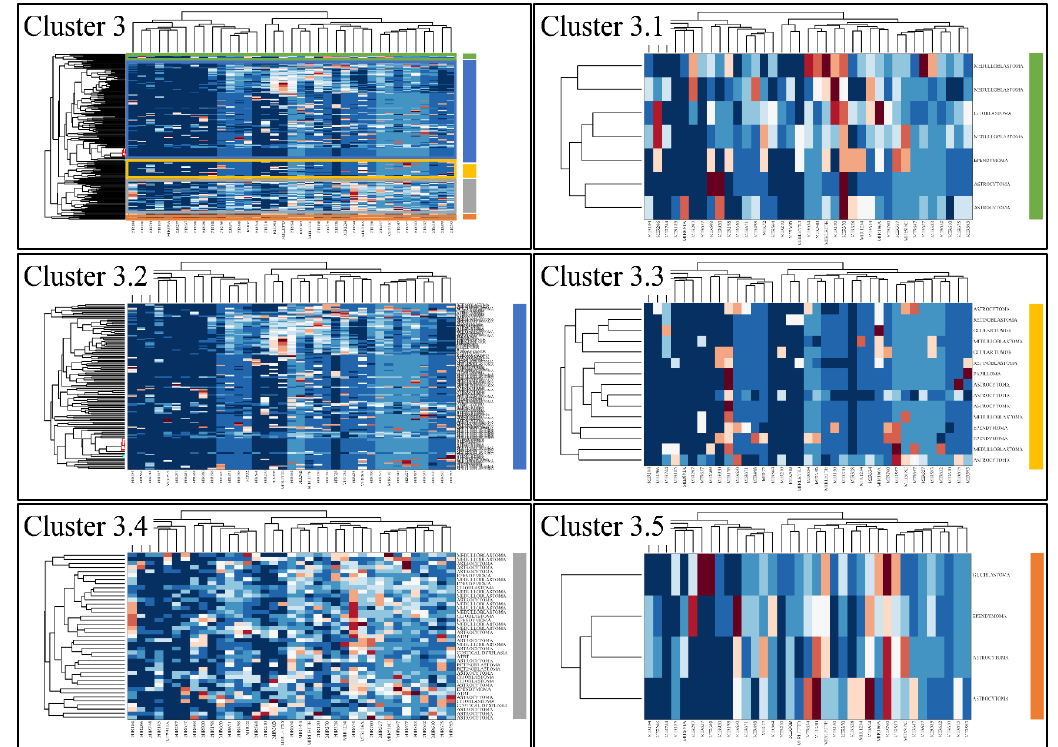
Figure 5. Hierarchical clustering (HCL) of cluster 2 as revealed previously by k-means clustering. The complete HCL is presented (Cluster 2) with its respective sub-clusters, denoted as clusters 2.1, 2.2, 2.3 and 2.4. In sub-cluster 2.3 miRNAs grouped together astrocytomas and medulloblastomas.